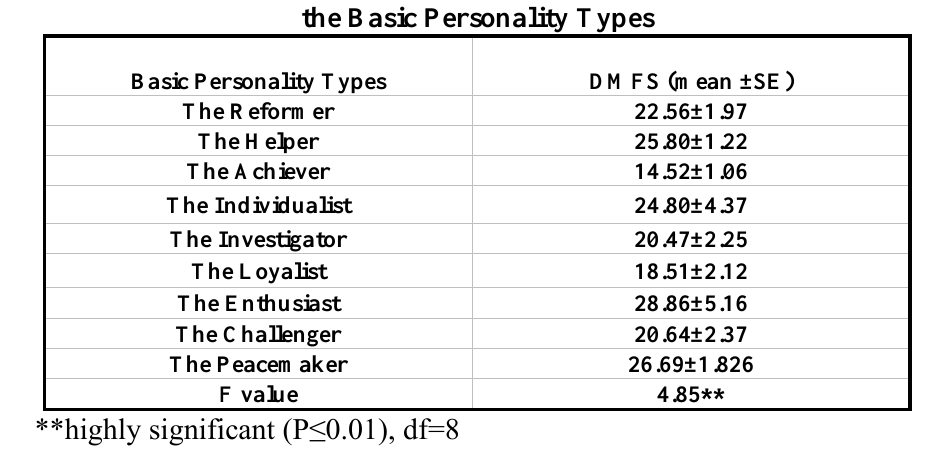
Table (2): The differences in caries experience (mean ±SE) among teachers according to